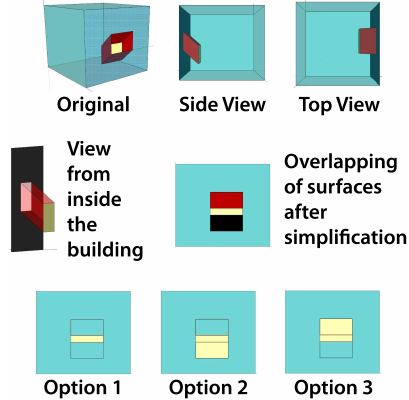
Figure 6. Window positioned at different level than the hole in the